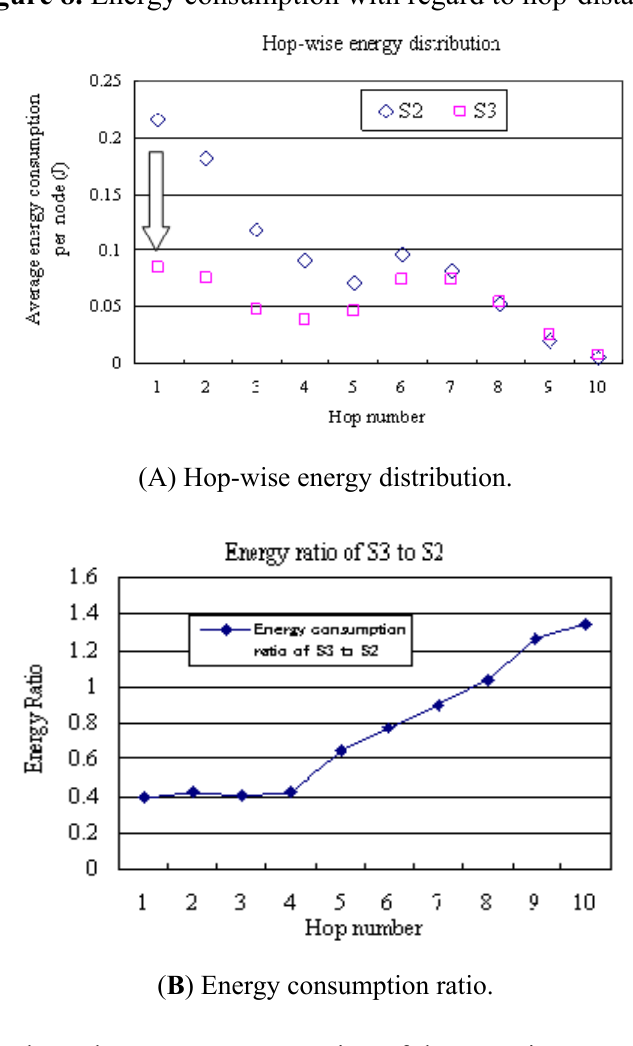
Figure 8. Energy consumption with regard to hop-distance.